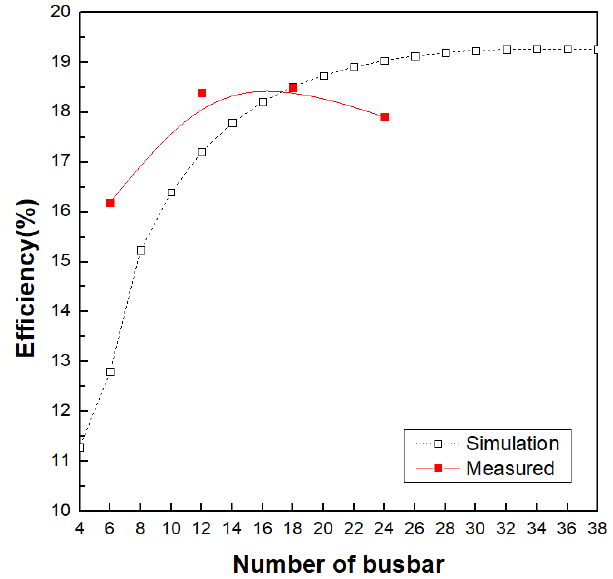
Figure 2. Simulated values and measured values based on the number of busbars for c-Si solar cell.